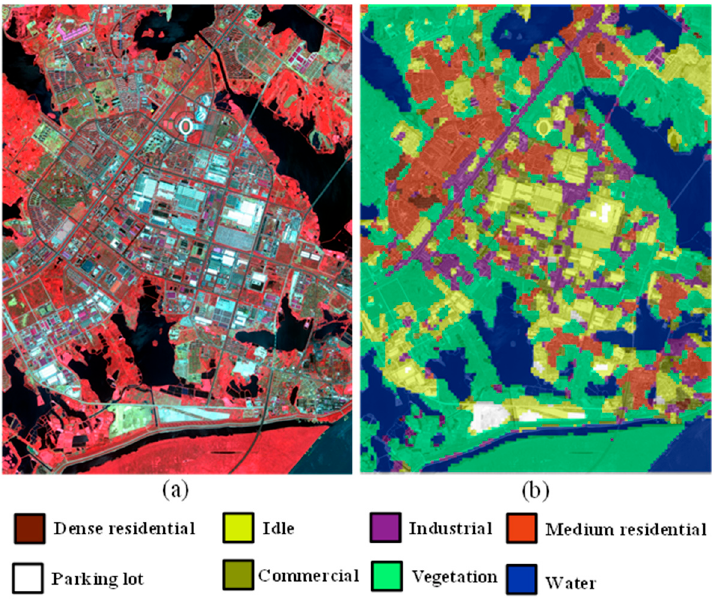
Figure 11. Image annotation using the Wuhan IKONOS dataset. ( a ) False-color image of the large image with 6150 × 8250 pixels. ( b ) Annotated large image.